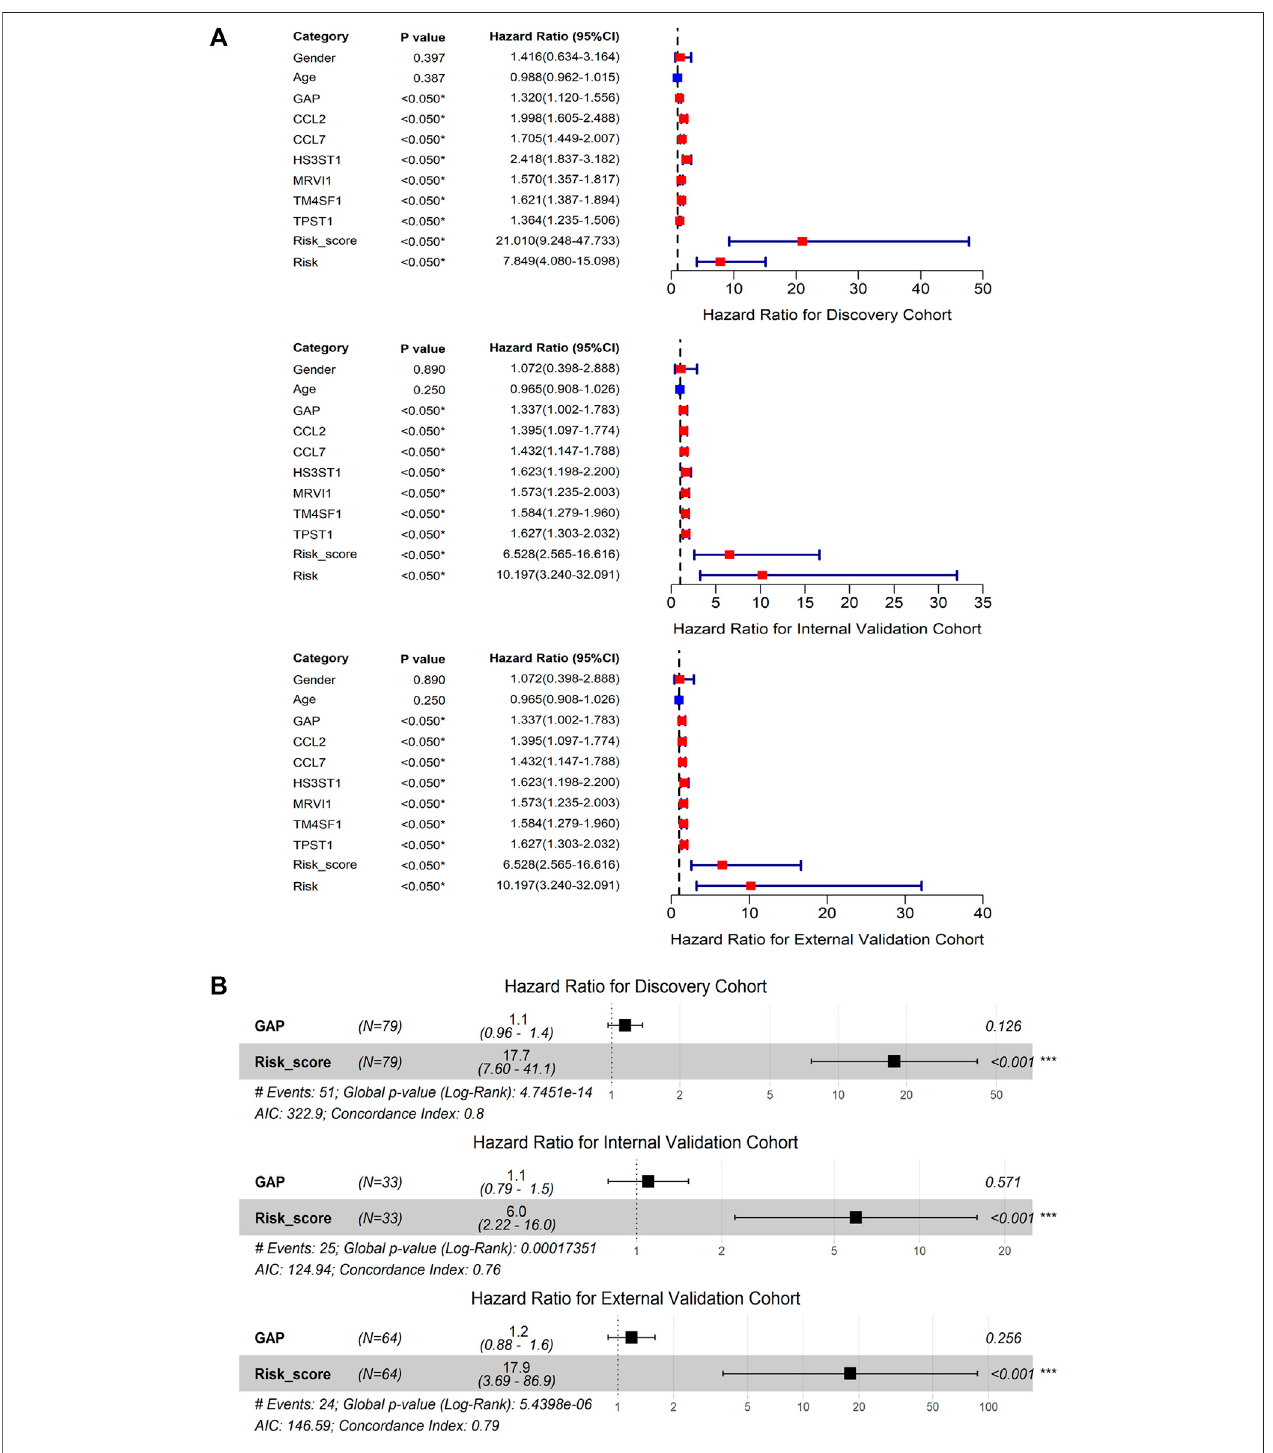
FIGURE5| Theprognosticvalueofm7GPSandclinicalcharacteristicsinIPF. (A) UnivariateCoxregressionanalysis. (B) MultivariateCoxregressionanalysis;*** p < 0.001. GAP, gender-age-physiologic variables.